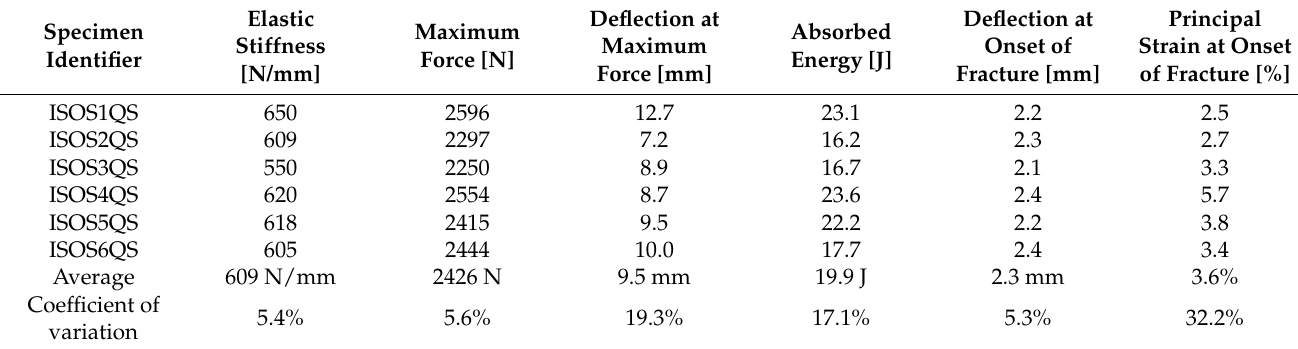
Table 5. Summary of quasi-static puncture mechanical responses.